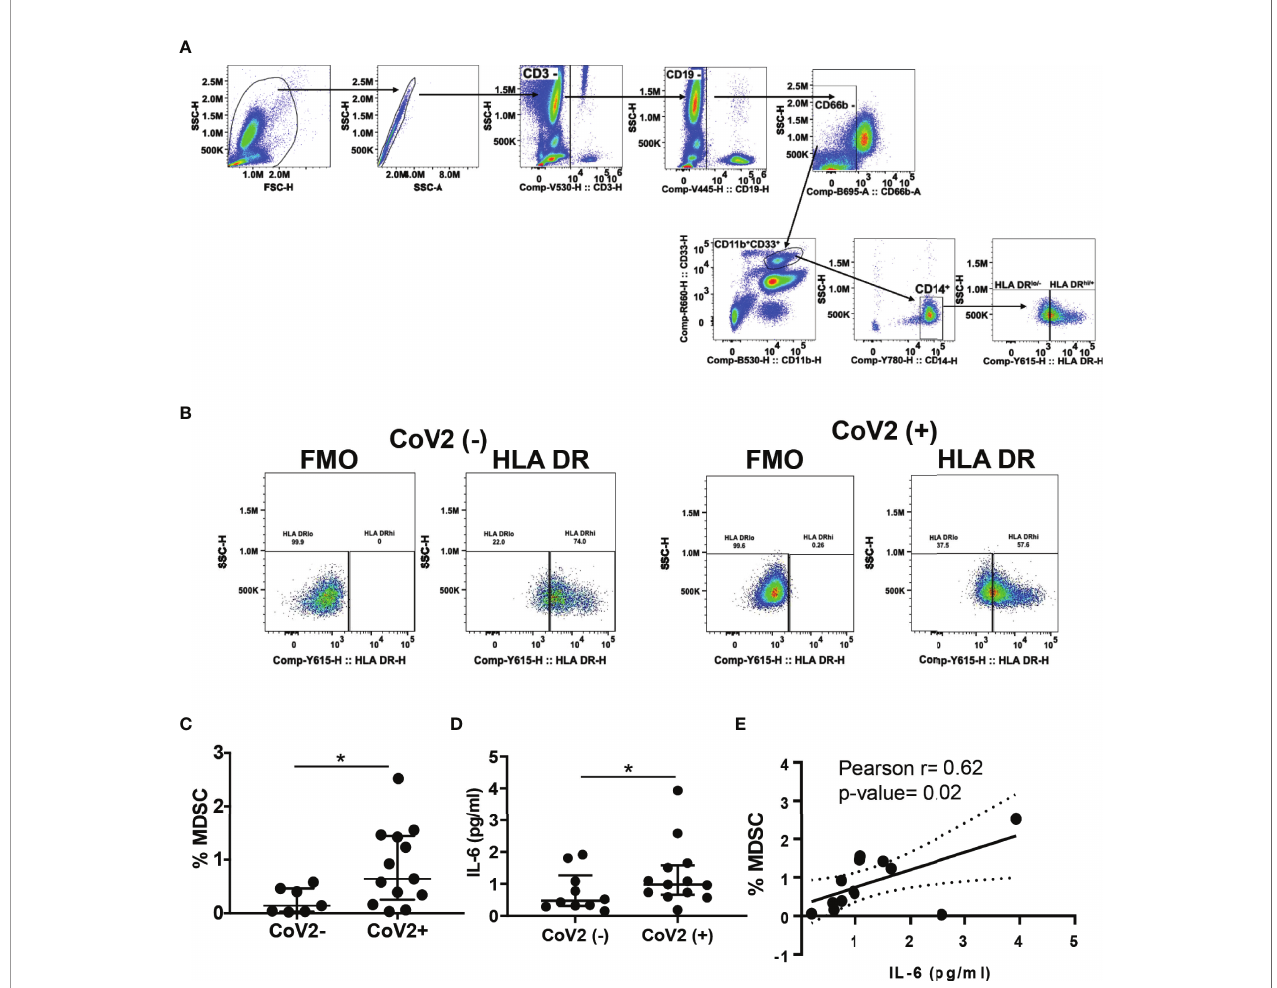
FIGURE 1 | M-MDSC expansion in CoV2+ individuals is dependent on IL-6: (A – C) Heparinized blood obtained from CoV2- and CoV2+ individuals was stained with anti- CD3, -CD19, -CD11b, -CD33, -CD14, CD66b, -HLA DR antibodies, cells were analyzed as CD3 - CD19 - CD66b - CD11b + CD33 + CD14 + HLA DR -/lo by fl ow cytometry. (A) Gating strategy for MDSC is shown (B) A representative dot plot with HLA DR-/lo region from CoV2(-)and CoV2(+)is shown. (C) Percentages of MDSC are shown. (D) The quantity of cytokine IL-6 in the plasma of CoV2- and CoV2+ individuals was measured by ELISA, as in Methods. (E) Plasma IL-6 quantity was correlated with the circulating frequency of M-MDSC in CoV2+ individuals. (C, D) Each dot in the plots depicts data of each individual donor, the plots include observations from 25 th to 75 th percentile. The horizontal line represents the median value. (D) Each dot in the plot depicts data of each individual donor; black solid and dotted lines, model-estimated values, and their 95% con fi dence intervals. *p <